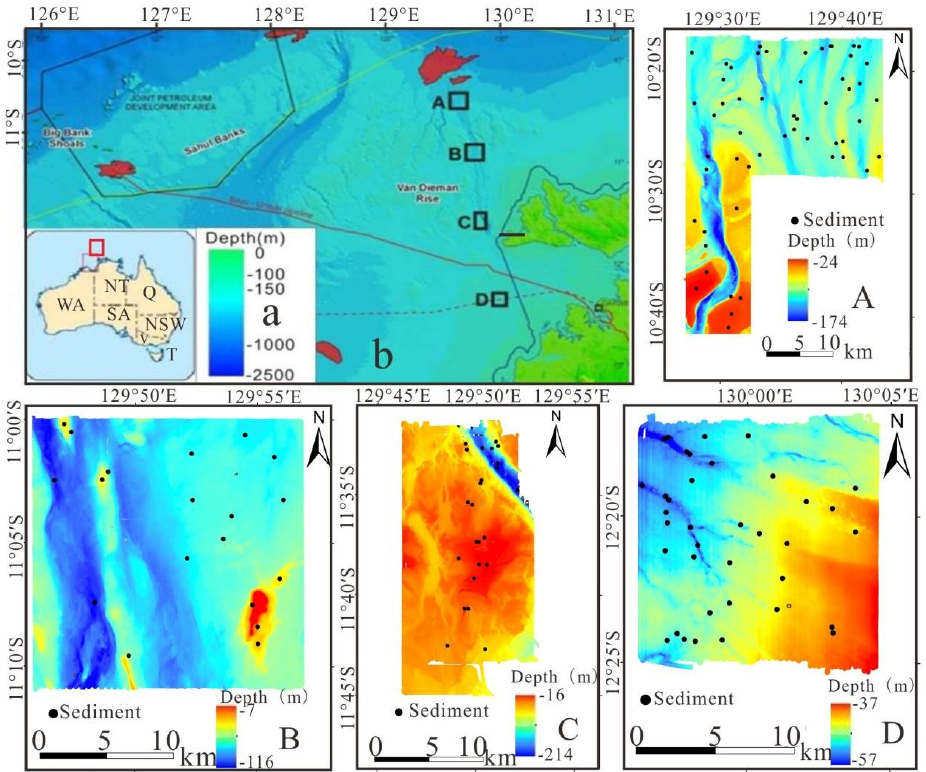
Figure 2. The study area and the sediment sample locations: ( a ). The relative location of study area in northern Australian and ( b ). The location of the four subregions on the continental shelf. ( A ). The mapping area BP_A; ( B ). The mapping area BP_B; ( C ). The mapping area BP_C; ( D ). The mapping area BP_D.